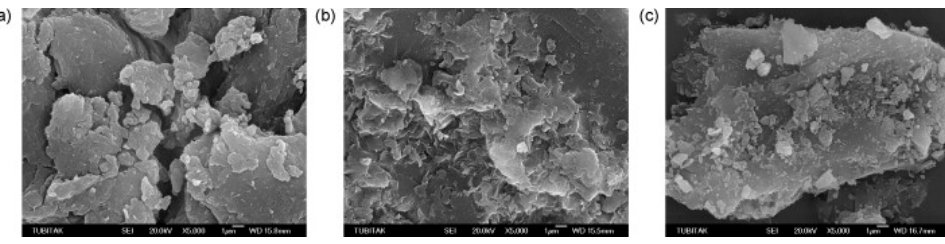
Figure 6. SEM views of polyacrylamide(PAAm) ( a ), polyacrylamide-bentonite(PAAm-B) ( b ), and polyacrylamide-zeolite(PAAm-Z) ( c ) [67].